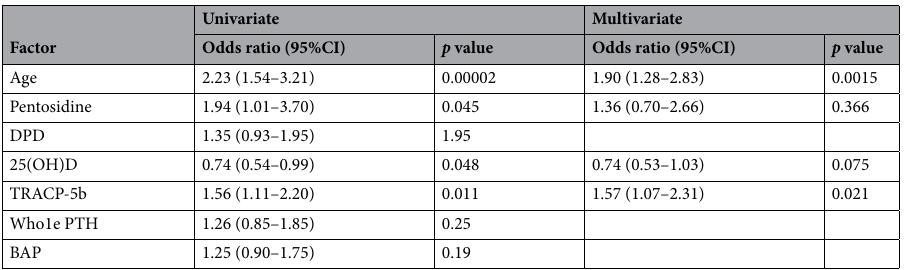
Table 6. Independent association between low BMD and bone markers in females. CI: confidence interval, DPD: deoxypyridinoline, 25(OH)D: 25-hydroxyvitamin D, TRACP-5b: tartrate-resistant acid phosphatase 5b, PTH: parathyroid hormone, BAP: bone alkaline phosphatase.